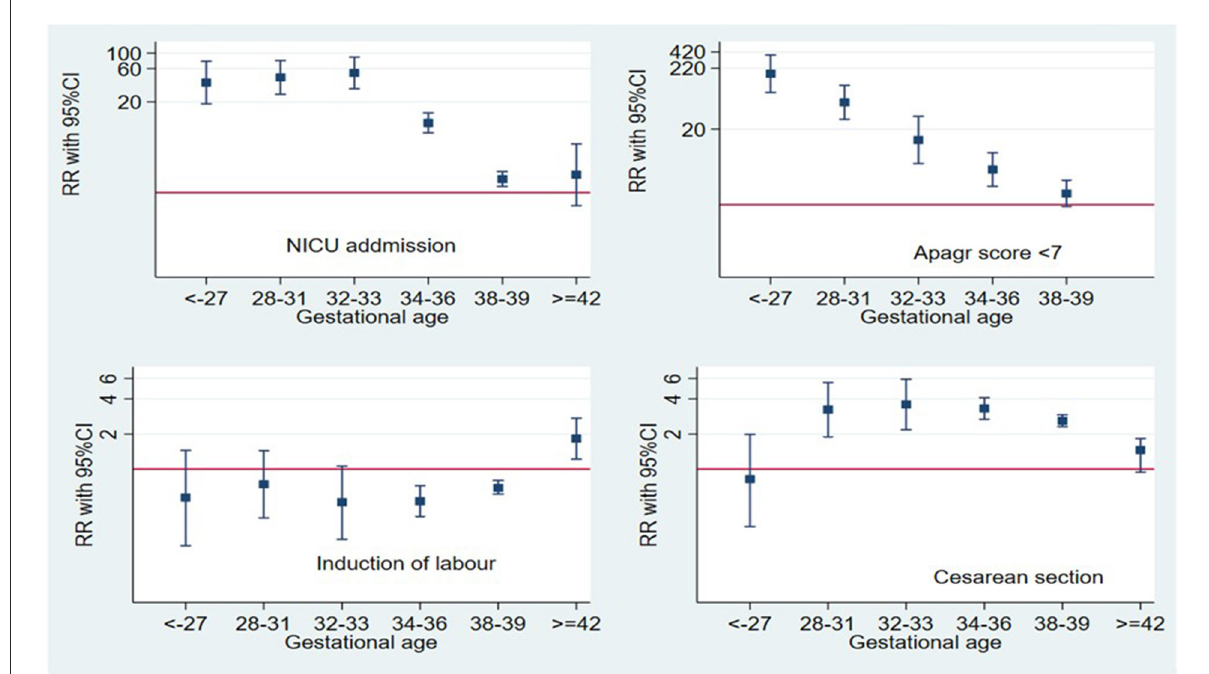
FIGURE2 Independent effects of gestational age at delivery on maternal and short-term neonatal